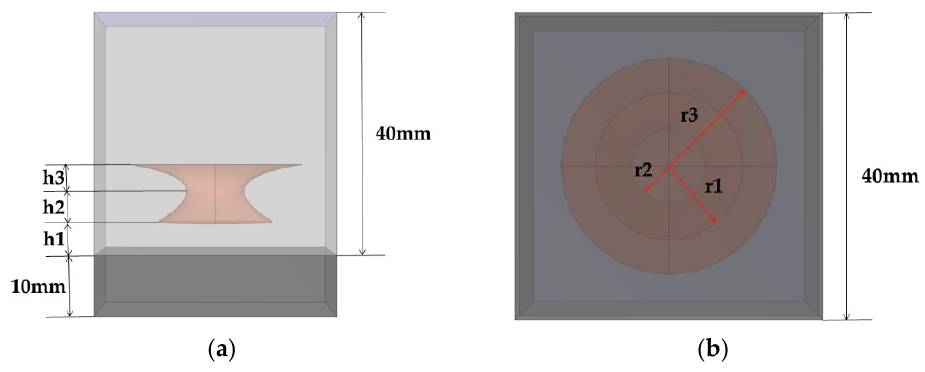
Figure 1. Sound ‐ absorbing structure model, ( a ) Elevation view; ( b ) Vertical view.